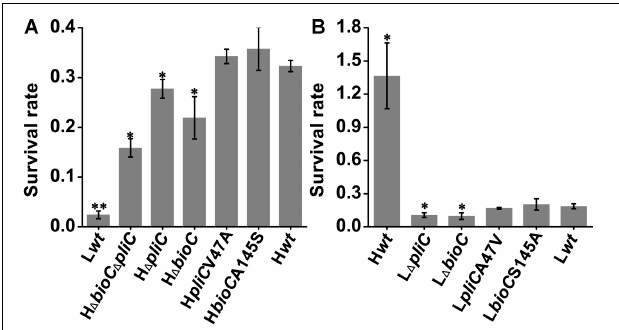
FIGURE 3 | Survival of bioC and pliC mutants in egg whites. The survival rates of bacteria represented as the ratio of the concentration of bacteria at 24-h/0-h samples incubated at 37 ◦ C with starting inocula of approximately (A) 2 × 10 3 and (B) 2 × 10 4 CFU/mL (the initial concentration increased by an order of magnitude here because the survival rates of SJTUF10984 and its mutants in egg whites were too low to distinguish between each other when the inoculum concentration was 2 × 10 3 CFU/mL). Survival rate is shown as the mean ± standard deviation. Experiments were repeated three times and results from one representative experiment were presented. ∗ p < 0.05 and ∗∗ p < 0.01, two-tailed t